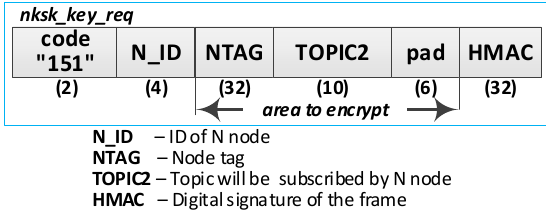
Figure 15. The node registration request frame.